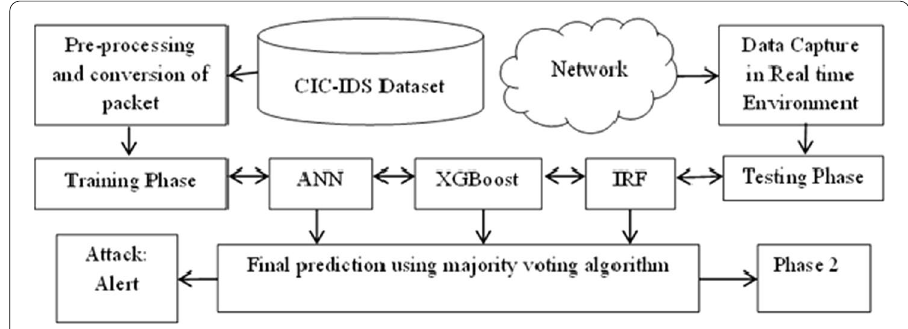
Fig. 2 BC-HyIDS phase 1: signature based detection architecture. Phase 1 architecture from proposed system is elaborated in figure. It shows input, output and processing steps for signature based attack detection. Classifiers used where artificial neural network, XGBoost and isolation random forest. All classifier are trained using CIC-IDS 2017 dataset. This is a standard intrusion detection dataset used for modern attack detection. Ensemble approach using majority voting algorithm is used to get final prediction as attack or normal